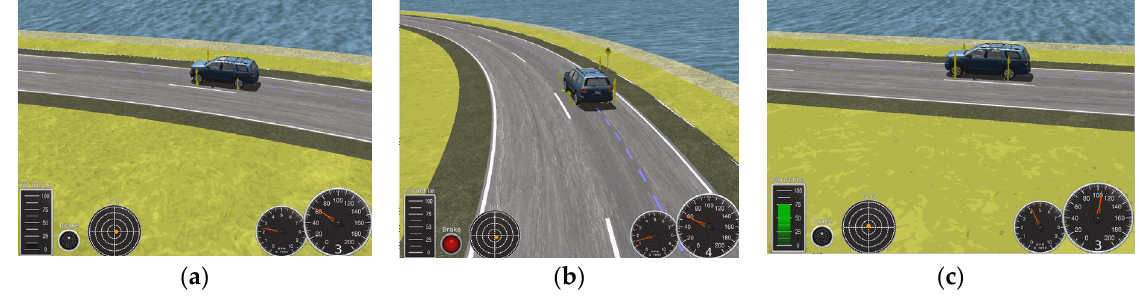
Figure 12. Brake simulation on a curved section: ( a ) constant speed; ( b ) steering deceleration; ( c ) acceleration driving.